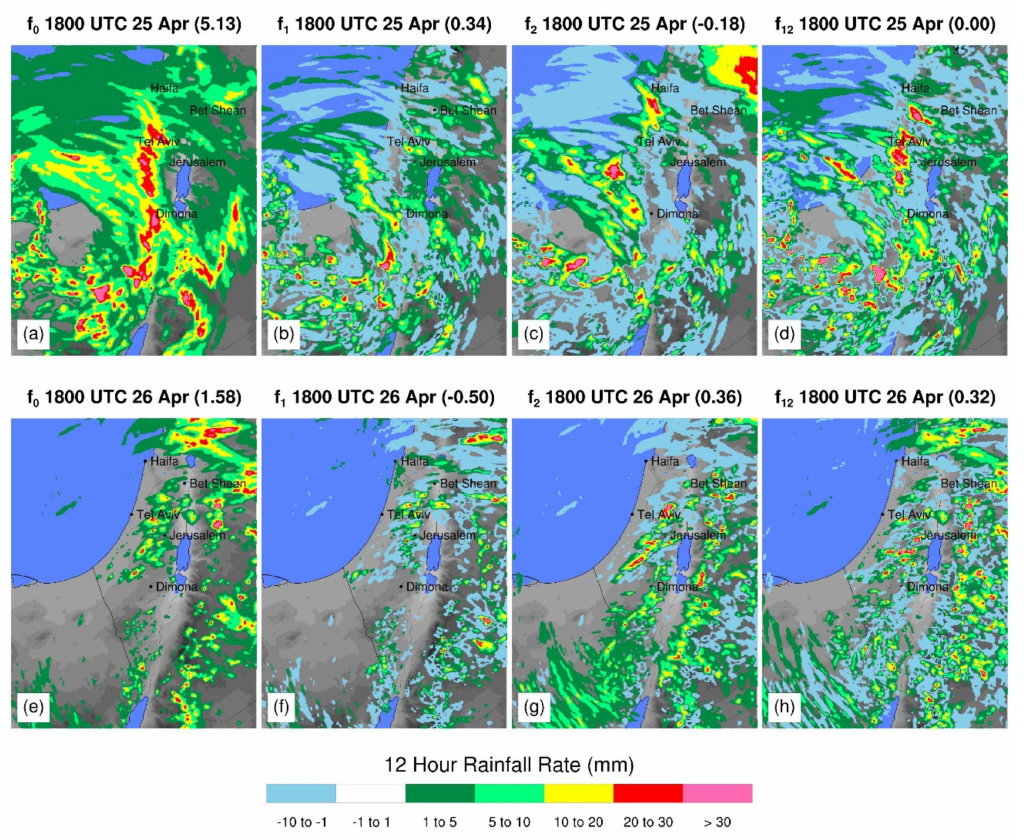
Figure 14. Same as Figure 13, but for 12 h rainfall